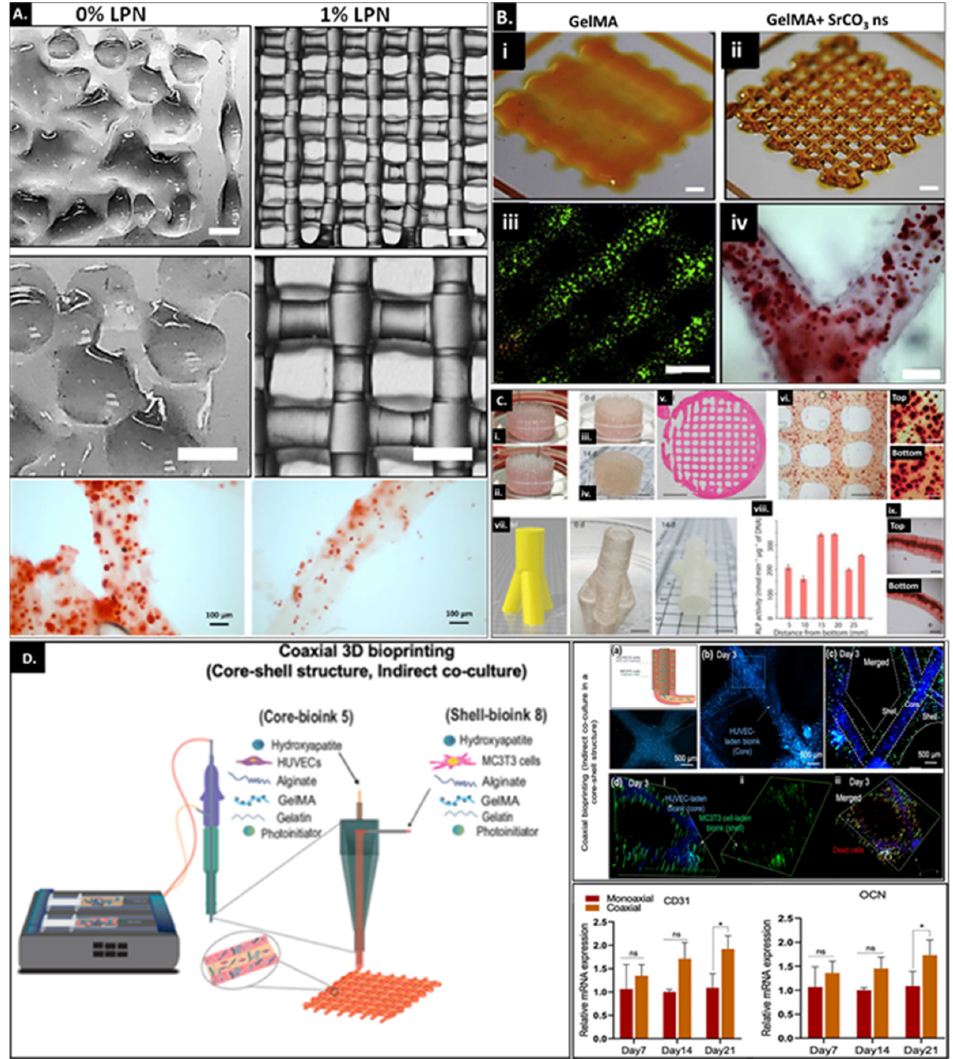
Figure 6. ( A ) Comparison of printing fidelity achieved by 7.5 wt% GelMA and 7.5 wt% nanocomposite bioinks incorporating 1 wt% LPN (Scale bars: 1 mm); low magnification (top panel) and high magnification (middle panel); bottom panel represents matrix mineralization of HBMSCs-laden 3D-printed LPN-GelMA construct cultured under osteogenic differentiation conditions (left) and media without dexamethasone (right) for 21 days. Adapted with permission from Ref. [51]. Copyright 2019, IOP. ( B ) Comparing printability of GelMA (i) with GelMA incorporating SrCO 3 nanostructures (ii) which also supports high cell viability of encapsulated MSCs as determined by live (green)/dead (red) staining (iii) matrix mineralization assessed via Alizarin Red staining of mineralized (CaP) nodules (iv) in bioprinted cell-laden Sr-GelMA scaffold. Adapted with permission from Ref. [52]. Copyright 2020, Elsevier. ( C ) GelMA+ (5 wt% GelMA with 5% gelatin crosslinked using LAP) bioprinted to form a porous cylinder construct (diameter, 2 cm; height, 1 cm) with Saos-2 cells in the bioink before (0